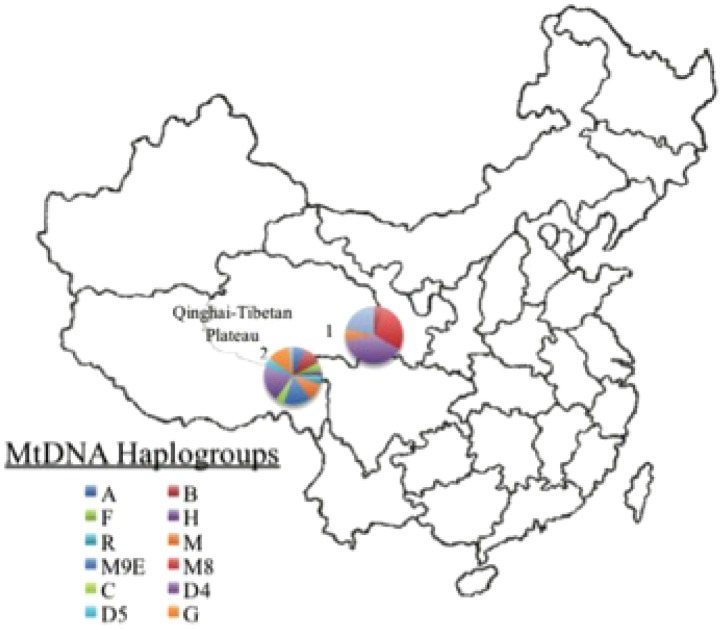
Map of two sample locations and mtDNA haplogroup frequencies from Maduo (represented by the furthest northeast) and Tuo Tuo River regions.Numbers 1 and 2 represent sample locations for Maduo [7] and Tuo Tuo River sample locations, respectively.